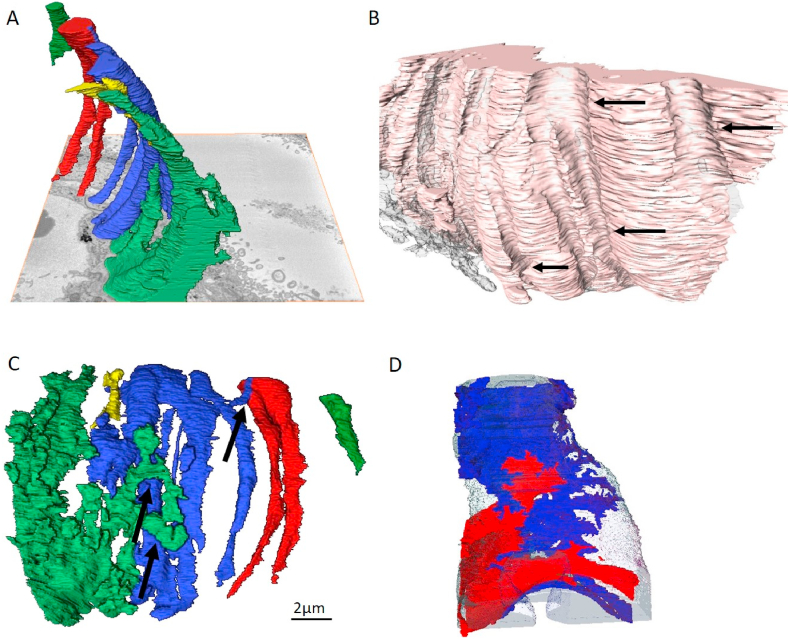
High-resolution 3D reconstruction of pericyte finger tips. (A) Fingers bend around the capillary away from the syncytiotrophoblast and (B) appear to leave indents on the endothelium of the capillary wall (pericytes are transparent. Indents indicated by arrows). (C) Pericyte fingers branch and in some cases overlap (arrows). (D) Two separate pericytes intertwine (one blue and the other red). The individual colours denote separate and discrete entities.